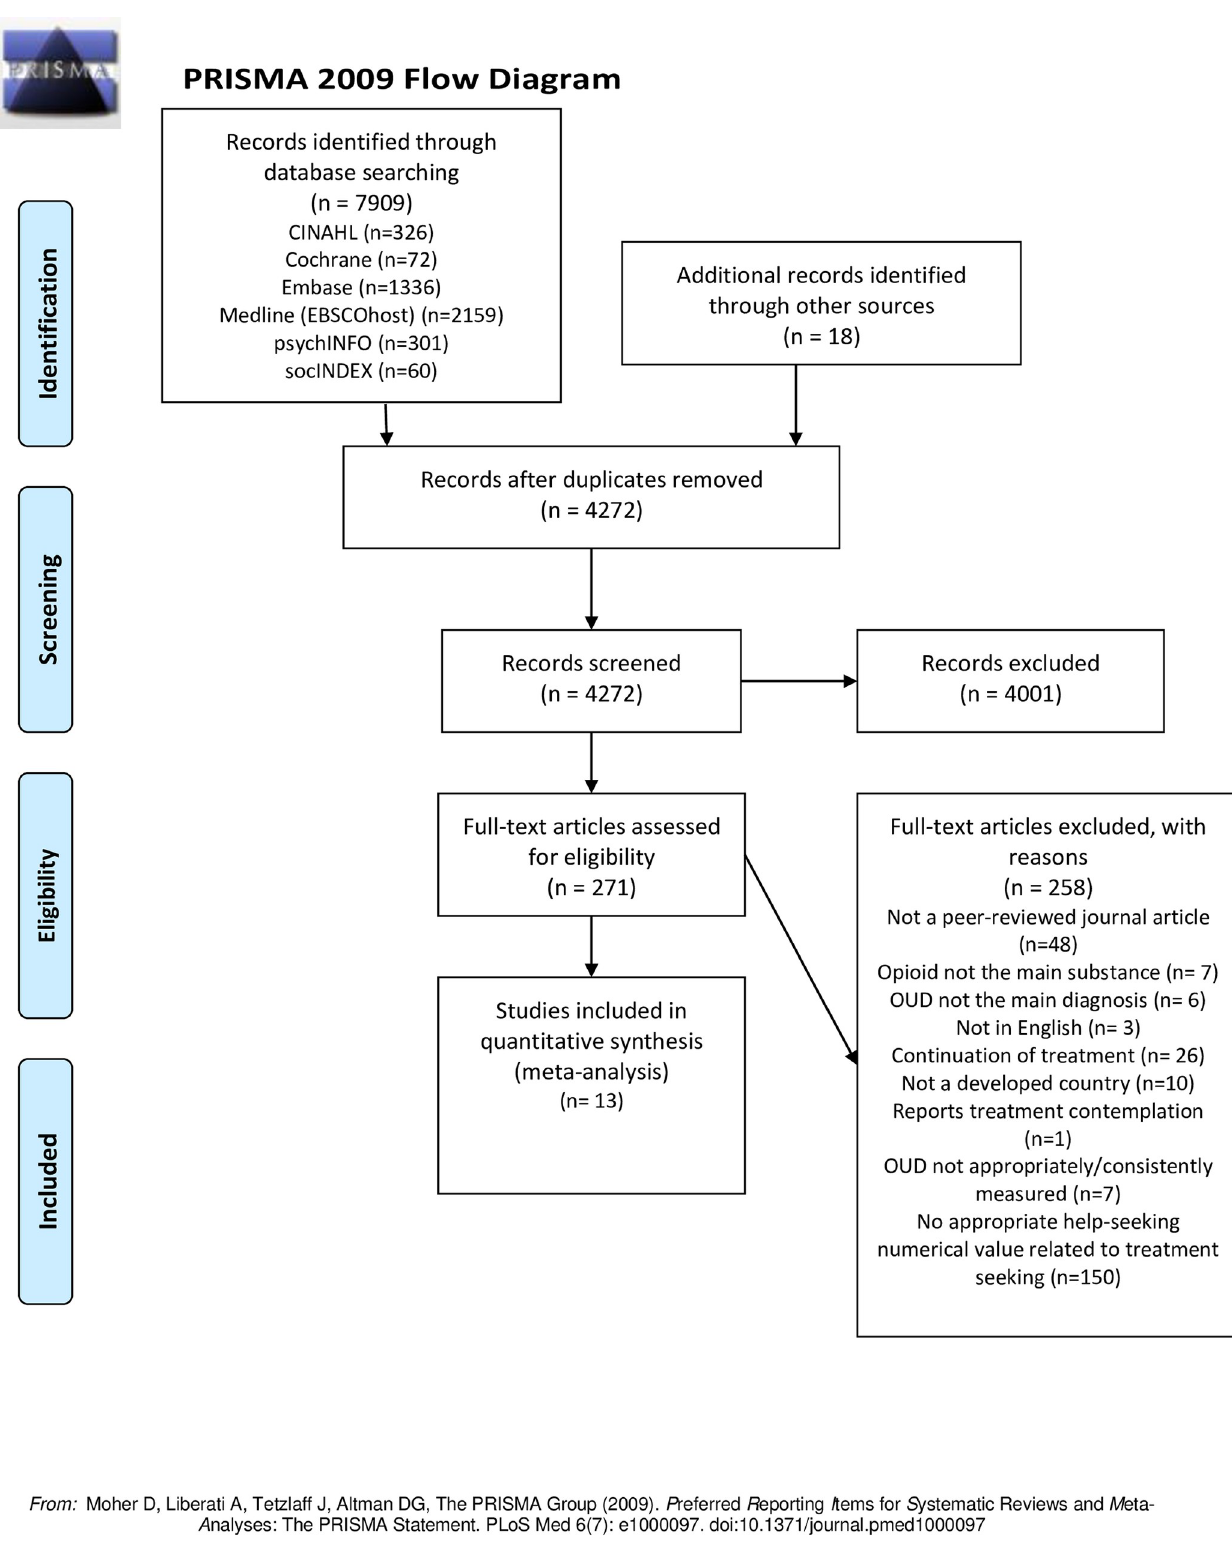
Fig 1. PRISMA flow diagram. https://doi.org/10.1371/journal.pone.0258620.g001 PLOS ONE | https://doi.org/10.1371/journal.pone.0258620 October 15,